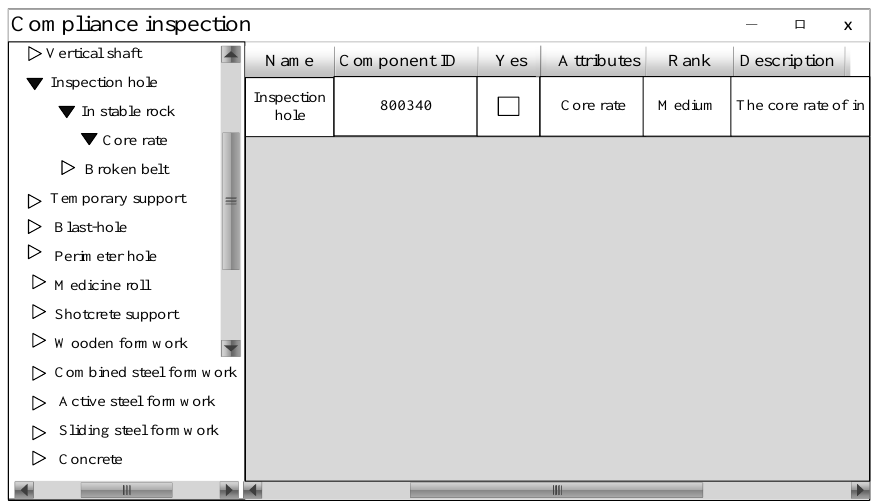
Figure 6. Inspection